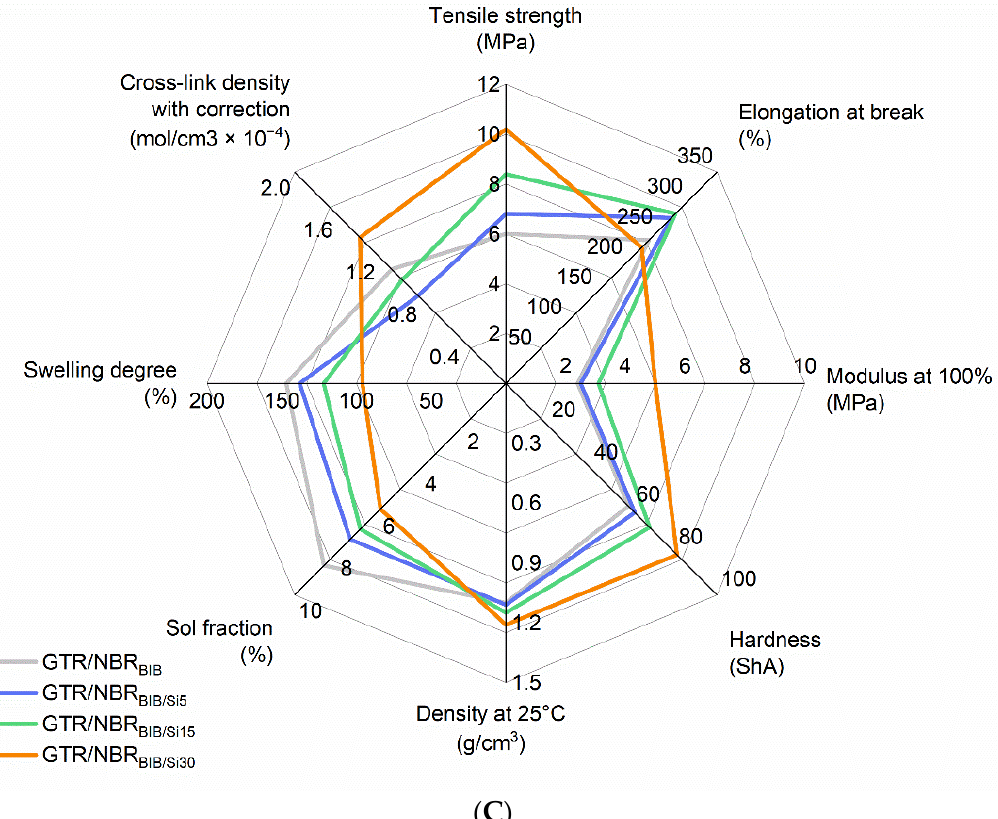
Figure 4. Spider chart representing the change of physico-mechanical properties of GTR/NBR samples in the function of highly dispersive silica content: ( A ) sulfur, ( B ) DCP, ( C ) BIB.